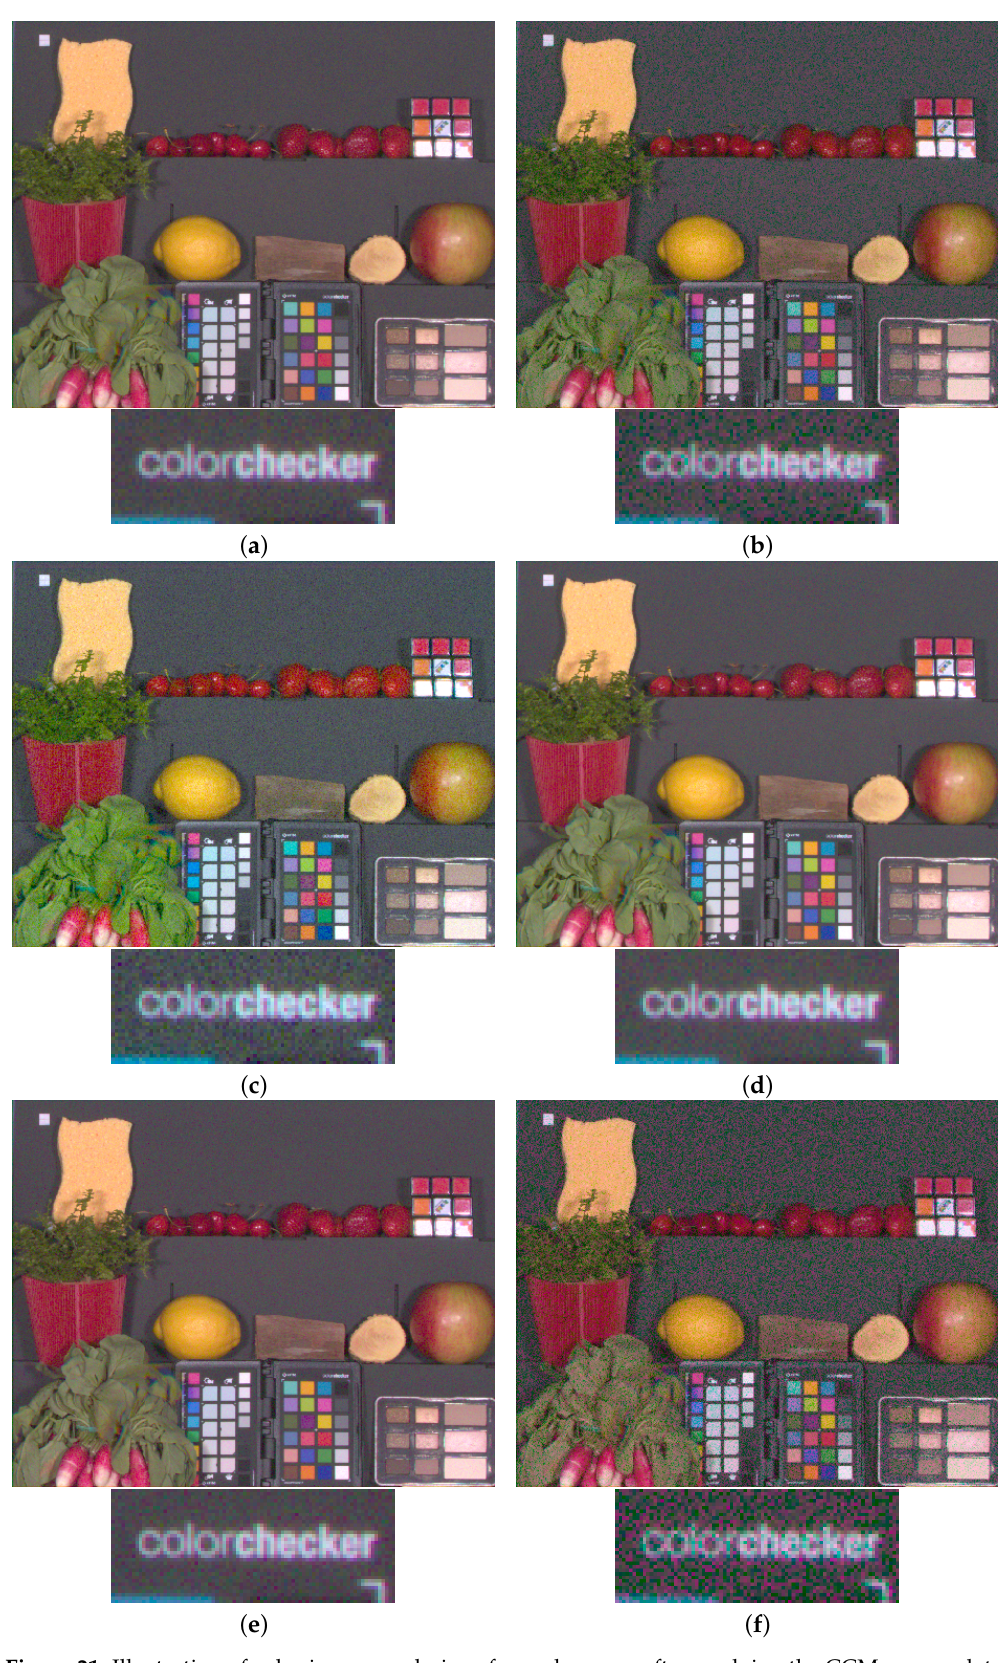
Figure 21. Illustration of color image renderings for each sensor after applying the CCM on raw data. Each frame is displayed with a zoom around the “colorchecker” word on the X-Rite ColorChecker Passport Photo. ( a ) RGB, ( b ) RGBW, ( c ) RGBWir, ( d ) CMY, ( e ) RYB, ( f )